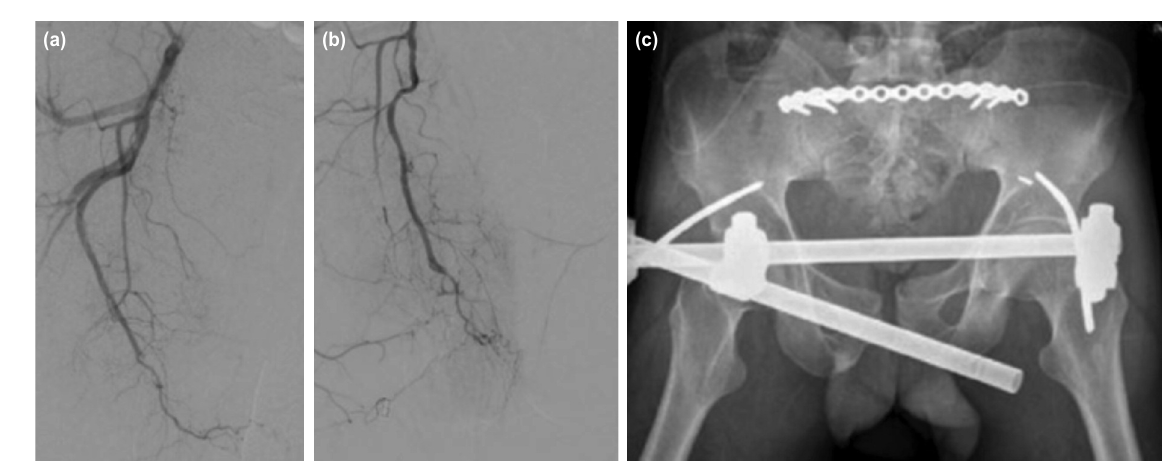
((a) Digital substraction angiography, selective right internal iliac artery (b) and superselective internal pudendal artery Fig. 3: angiogram did not reveal any active contrast leak. (c) Post-operative radiograph of pelvis reveals posterior plating of the sacral fracture alongwith supra-acetabular fixator application for the pubic diastasis